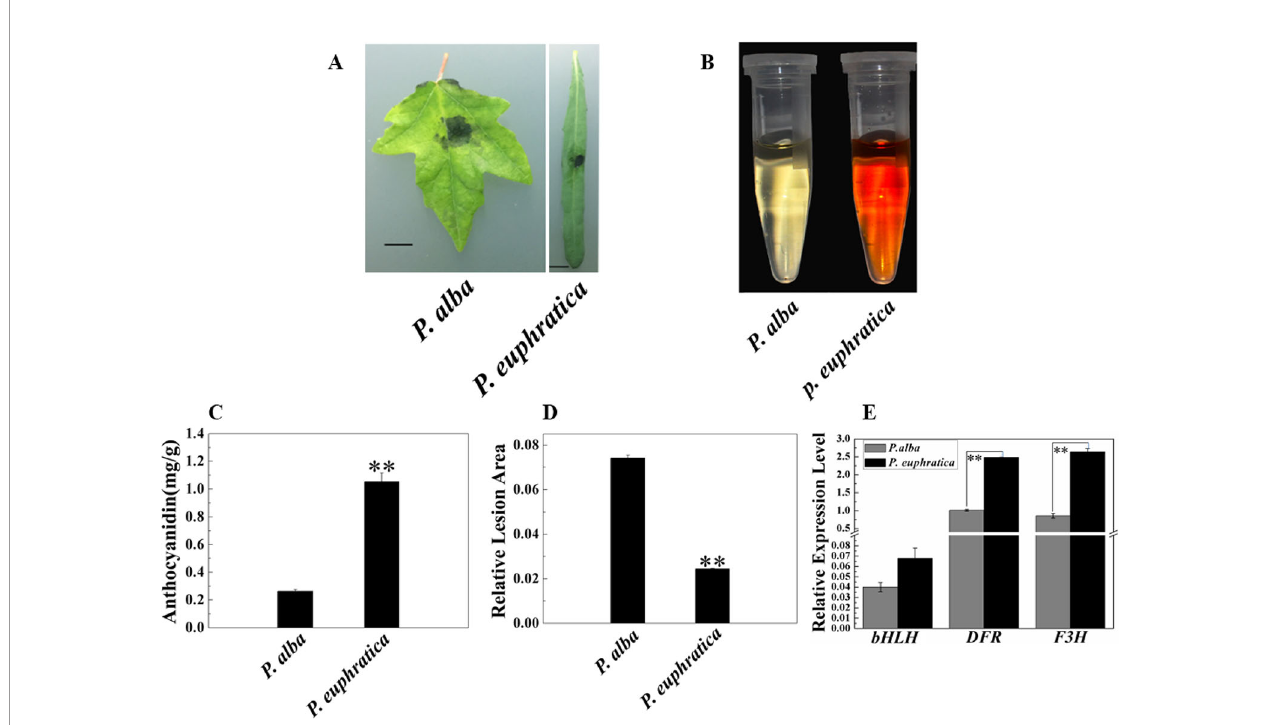
FIGURE 7 | Relationships of anthocyanin content and responses to pathogen infection in P. alba var. pyramidalis and P. euphratica leaves. (A) Disease symptoms induced by D. gregaria on the leaves of two sister poplars, P. alba var. pyramidalis and P. euphratica . (B) Colors of anthocyanin extracted from P. alba var. pyramidalis and P. euphratica leaves. (C) Total anthocyanin contents in P. alba var. pyramidalis and P. euphratica leaves. (D) Relative lesion areas of the third leaves of P. alba var. pyramidalis and P. euphratica plants after D. gregaria infection for 7 days. (E) Relative expression levels of bHLH1 , DFR , and F3H in P. alba var. pyramidalis and P. euphratica leaves. Error bars indicate the standard error (SE) of the average anthocyanin content, ** P <